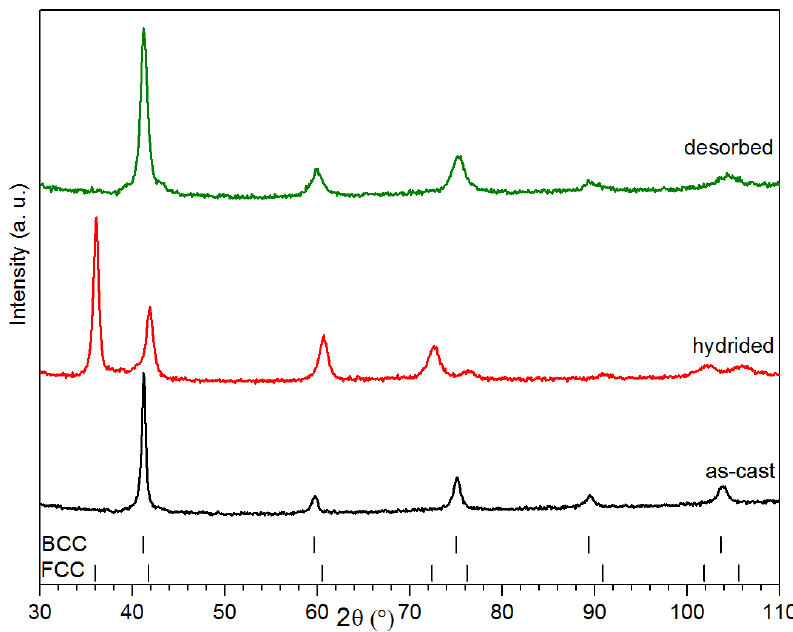
Figure 3. XRD pattern of the co-melt Ti 1.56 V 0.18 (FeV) 0.18 Cr 1.08 + 4%Zr 7 Ni 10 alloy in as cast, fully hydride, and desorbed state.